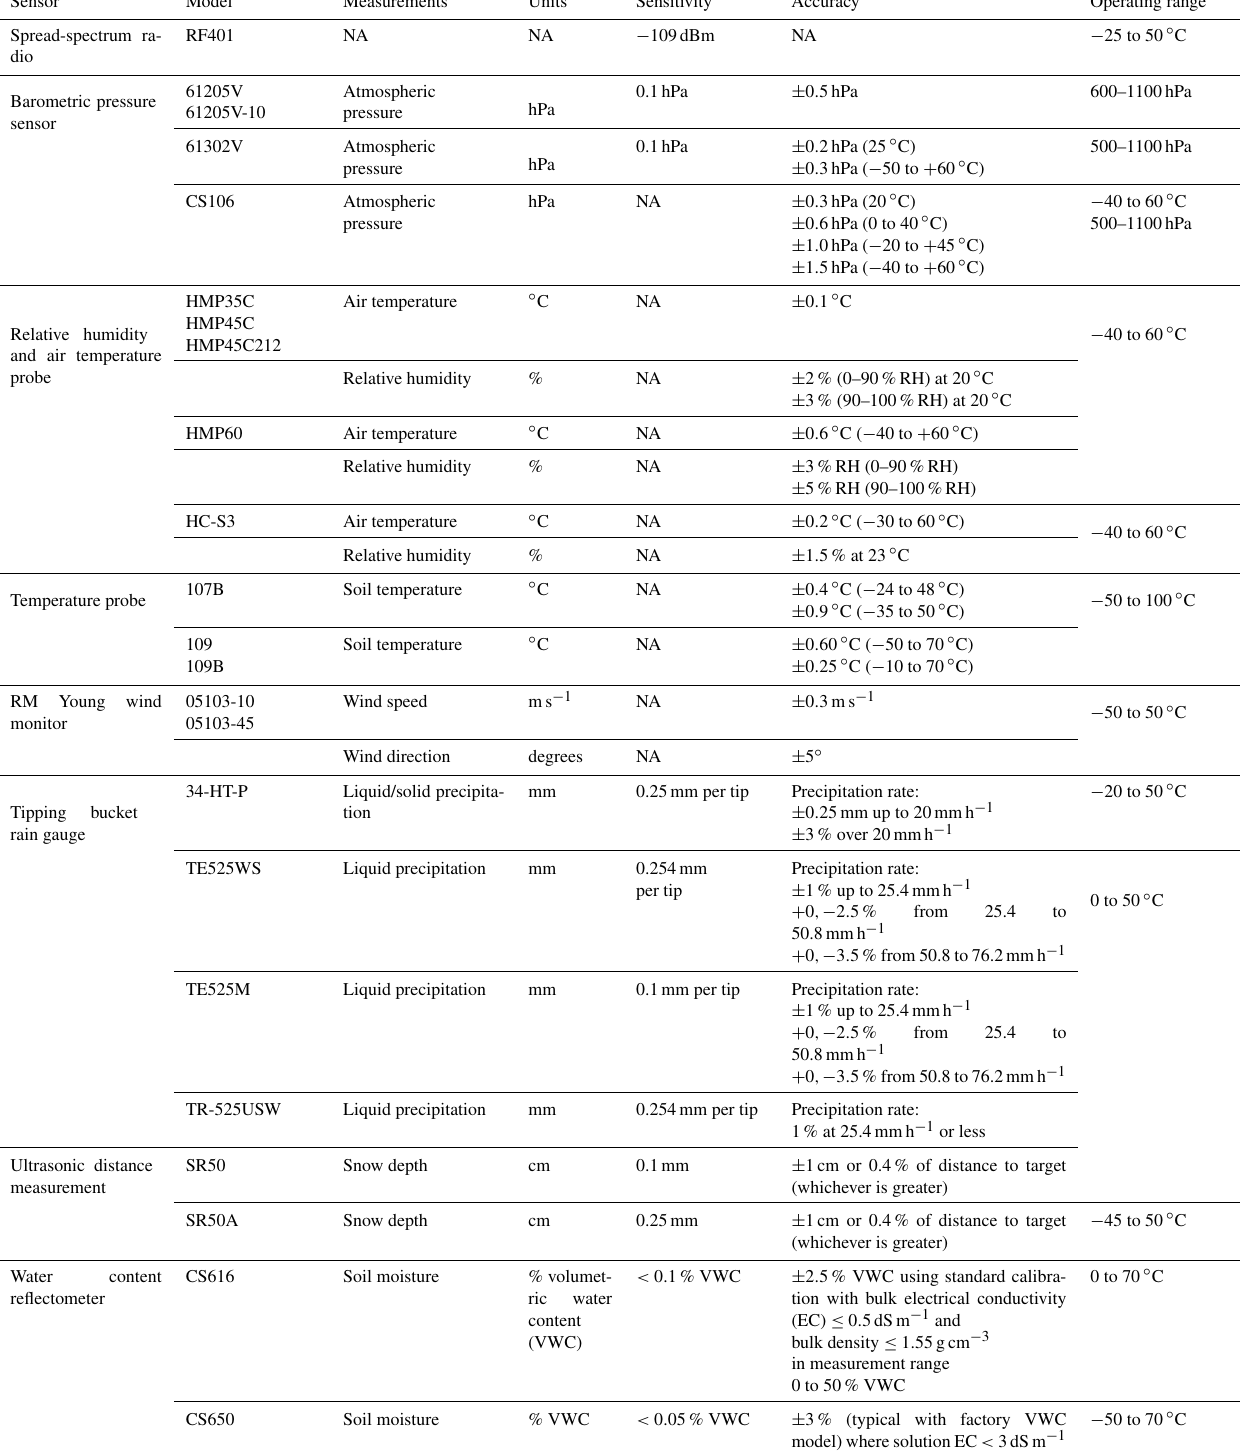
Table 2. Specifications for sensors used at each CAMnet station. NA – not available.